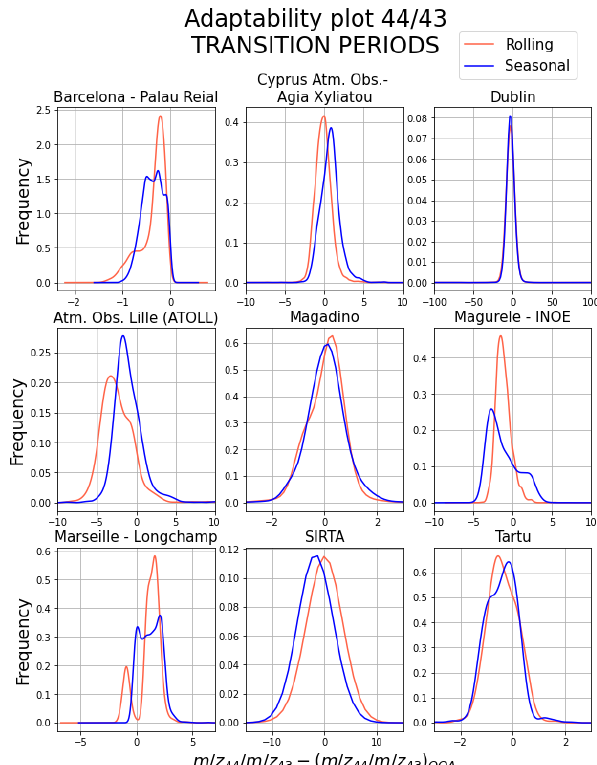
Figure 8. Kernel density estimation of the histograms of the sub- traction of the m/z 44-to-43 ratio from the raw (from input matrices) time series data minus the apportioned quantity in profiles. These plots only contain those time lapses among the change of season (transition